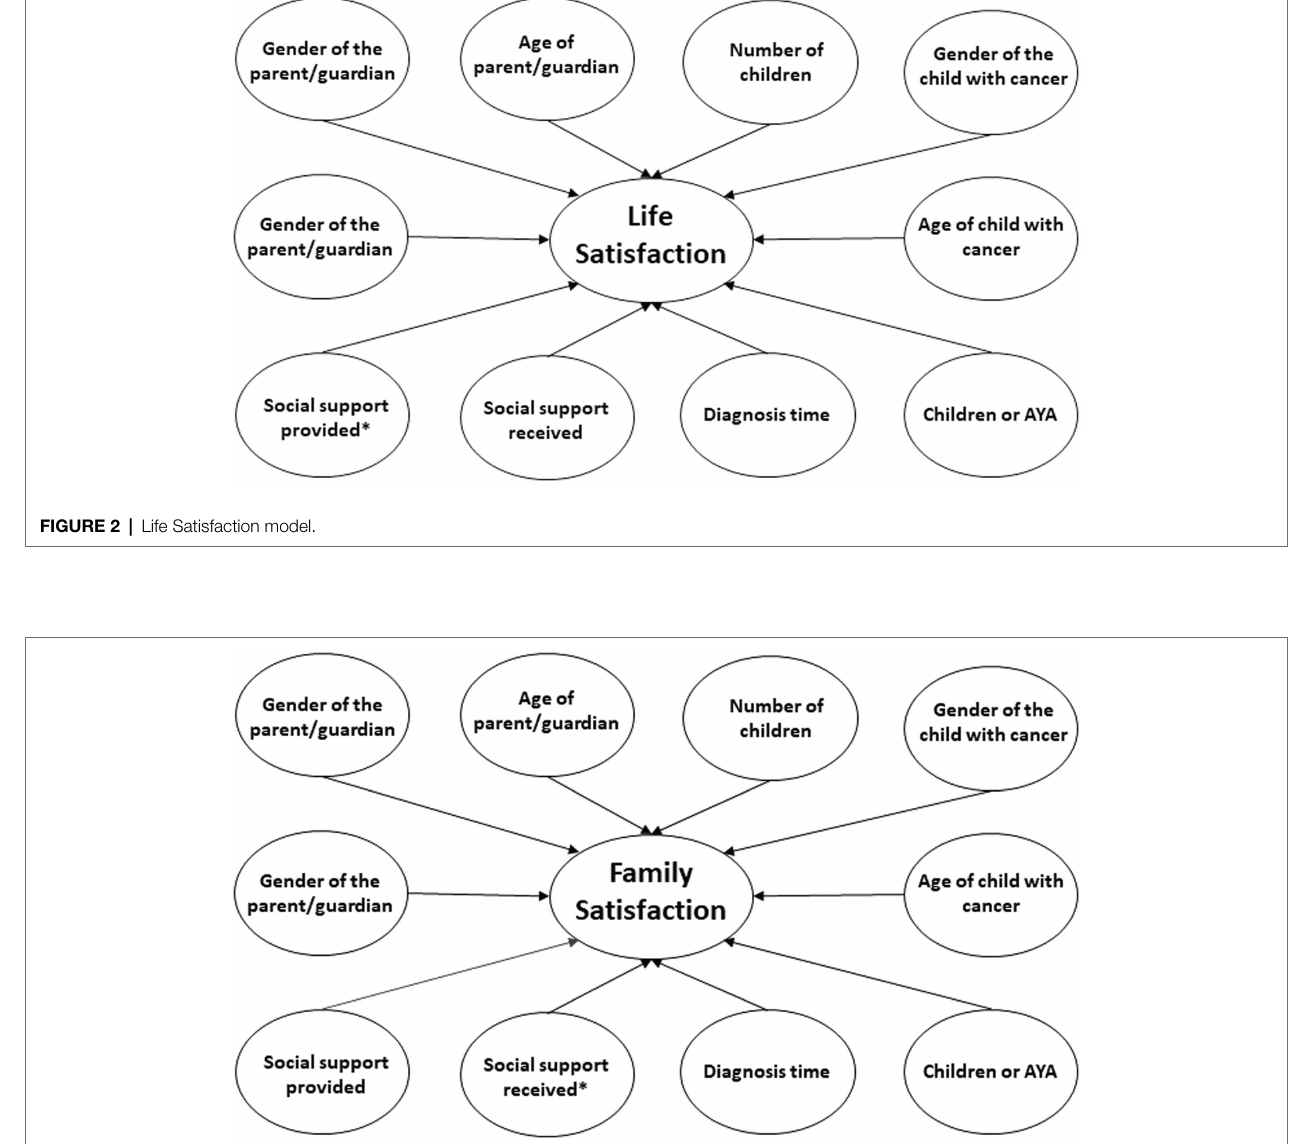
FIGURE 3 | Family Satisfaction